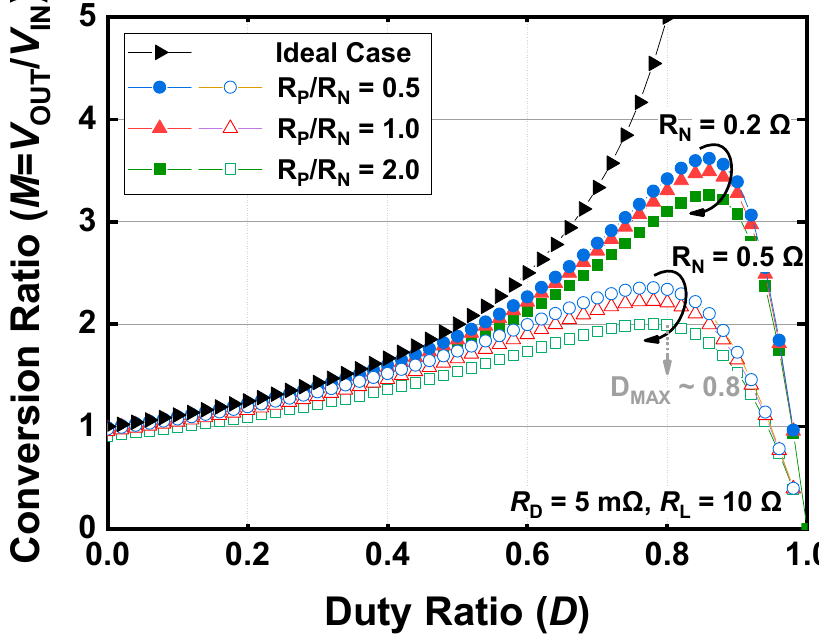
Figure 2. Voltage conversion ratio with respect to the duty ratio.